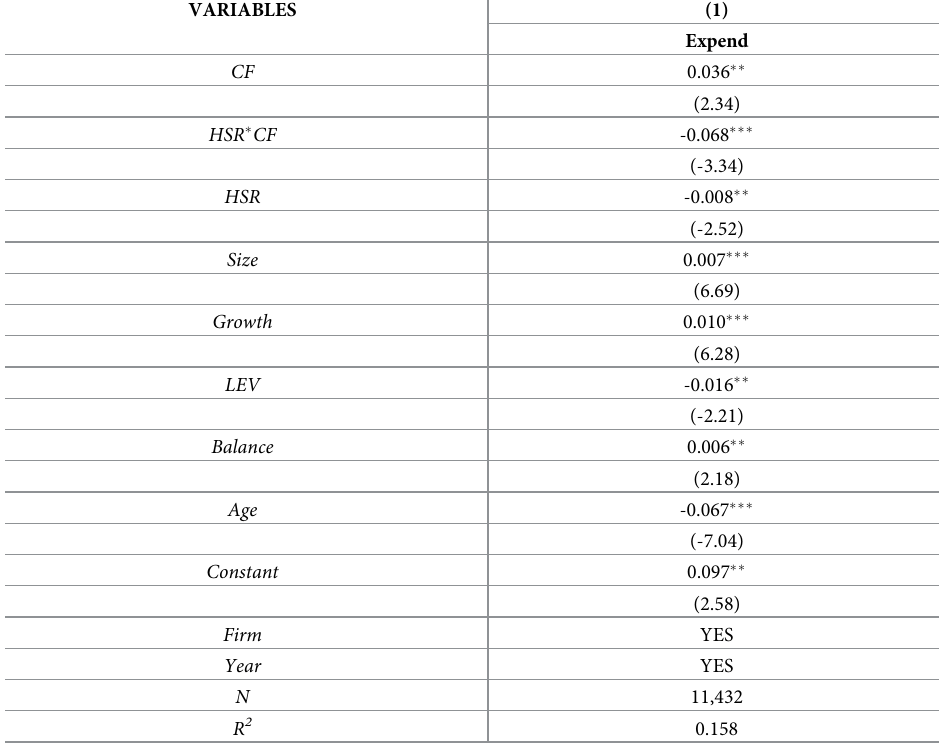
Table 11. Regression results of investment-cash flow sensitivity